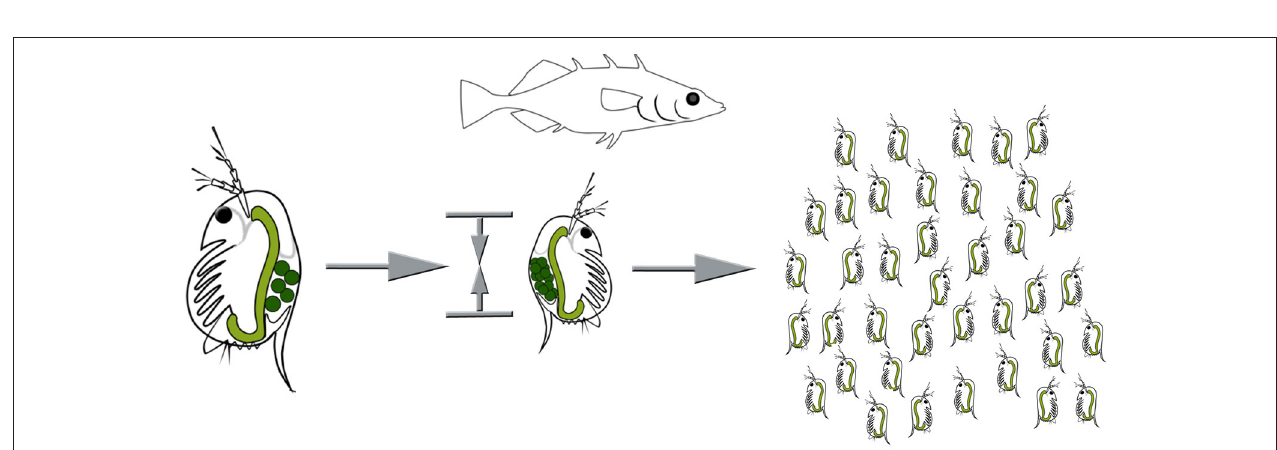
FIGURE 2 | Life history adaptations under fish predation. Resources are shifted from somatic growth to reproduction, resulting in earlier sexual maturity at a smaller size, and an increased number of smaller offspring. Images by Weiss.